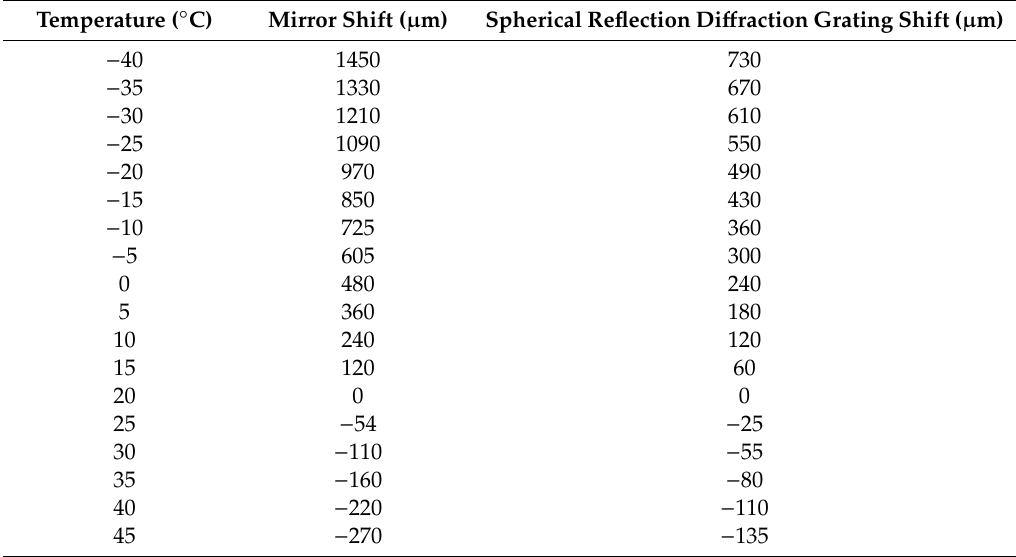
Figure 9. Experimentally measured point spread functions (PSFs; interpolated by 5.5 × 5.5 µm pixels) at 35 °C without optical scheme adjustment.